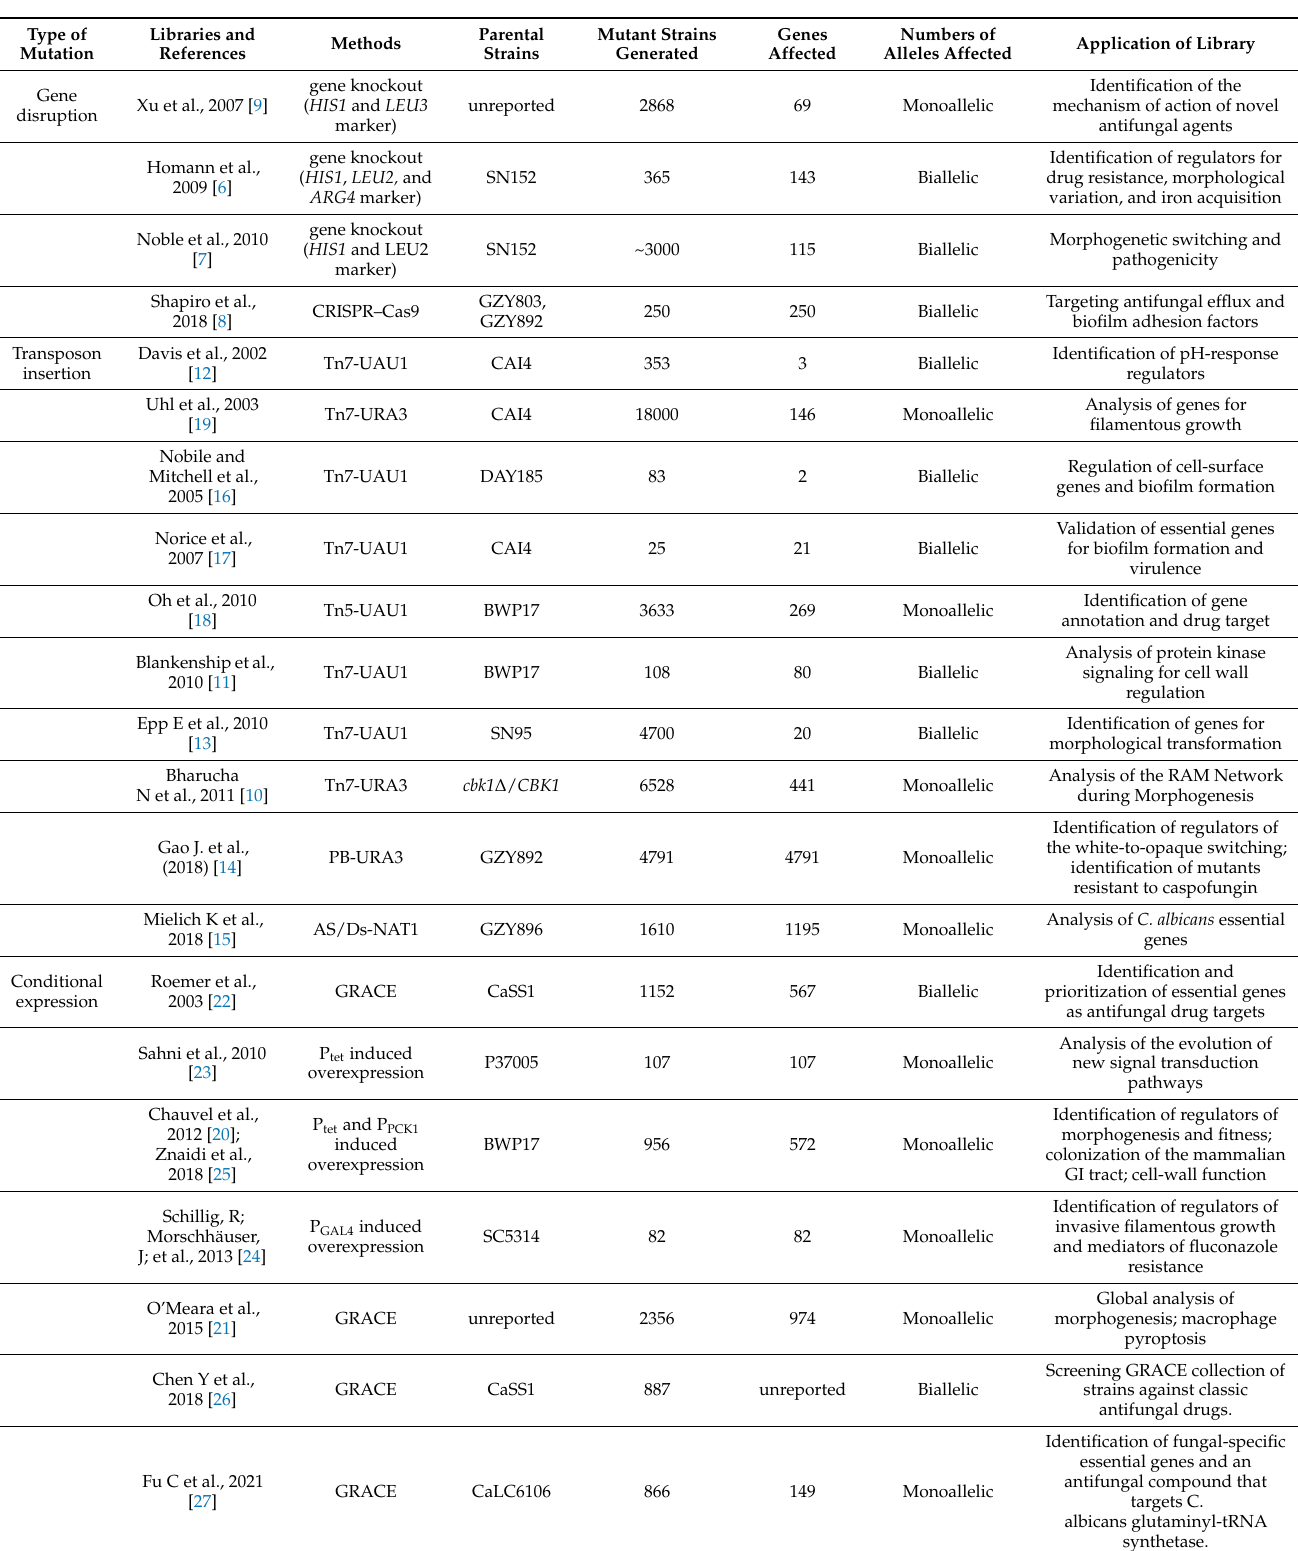
Table 1. C. albicans mutant libraries for gene function